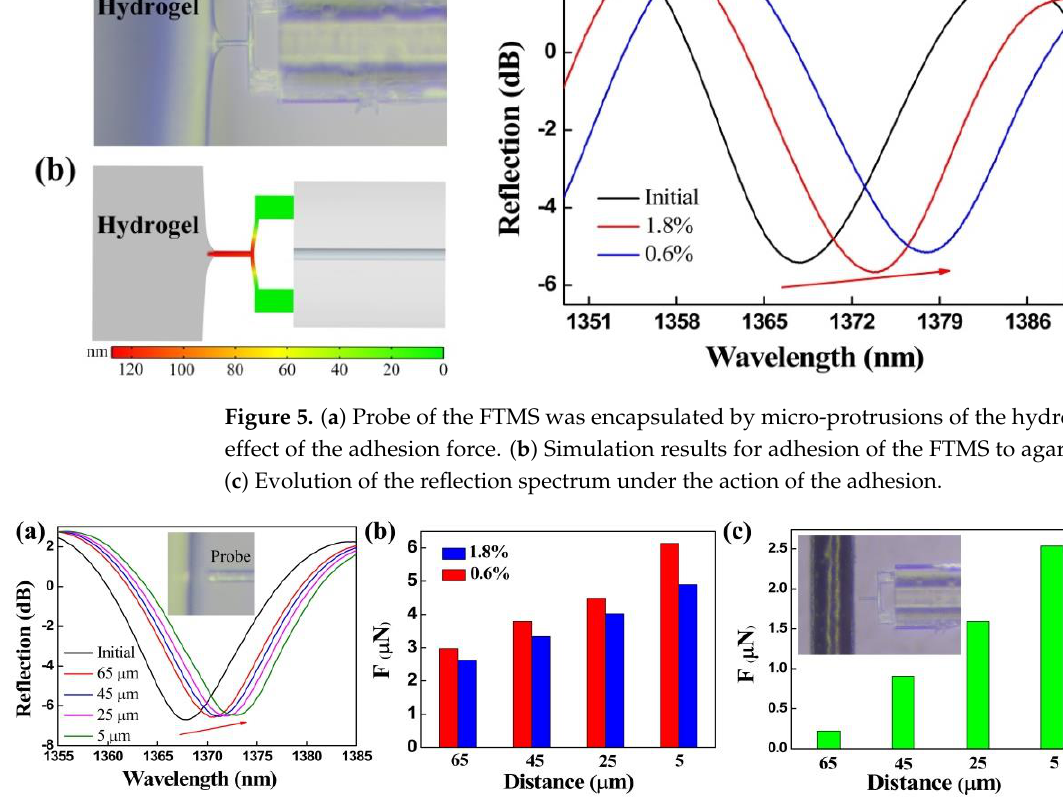
Figure 6. ( a ) Drift of the FTMS reflection spectrum under the action of the noncontact adhesion force of hydrogels. ( b ) Noncontact adhesion forces between the probe and the agarose hydrogels at different distances. ( c ) Noncontact adhesion forces measurement of human hair.